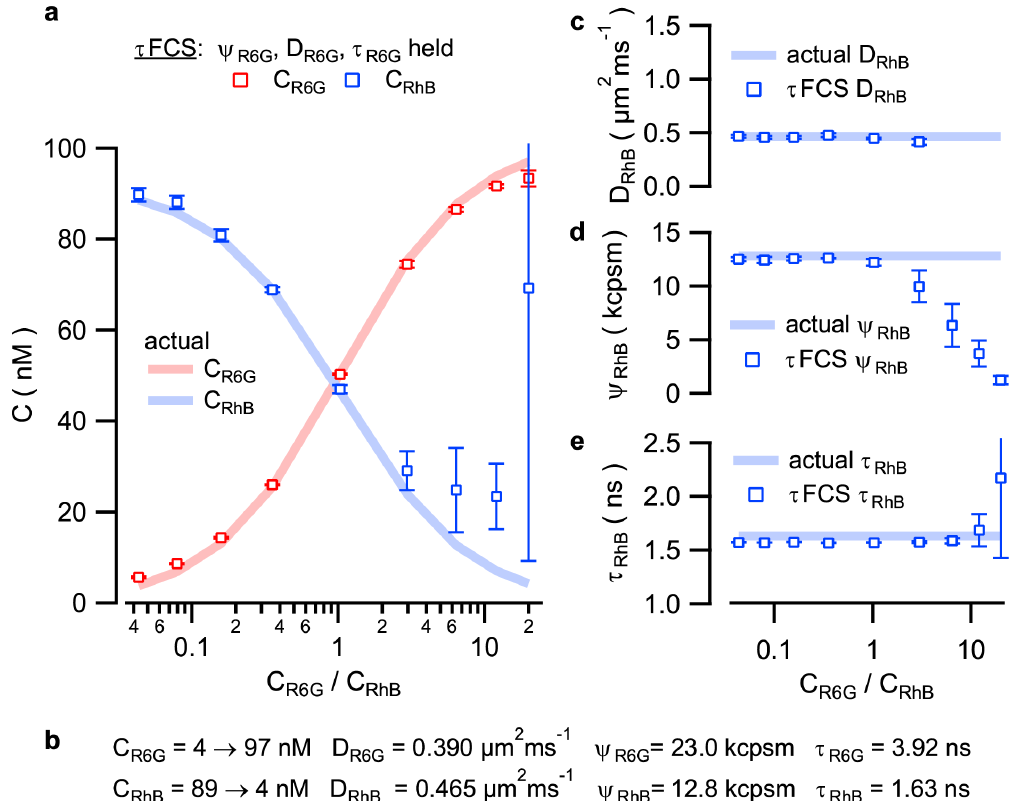
Figure 1. t FCS analysis of binary dye mixtures with known R6G and RhB concentrations. (a) Recovery of molecular concentrations across nine known concentration ratios using t FCS. Measured concentrations are shown as red and blue squares, and the solid lines show the known concentration of each dye mixture. (b) Sample parameters detailing concentrations, diffusion coefficients, molecular brightnesses and fluorescence lifetimes of the prepared R6G and RhB mixtures. Recovery of RhB diffusion coefficient (c), molecular brightness (d), and fluorescence lifetime (e) respectively. Data points and error bars represent the average and standard deviation of three repeated experiments.